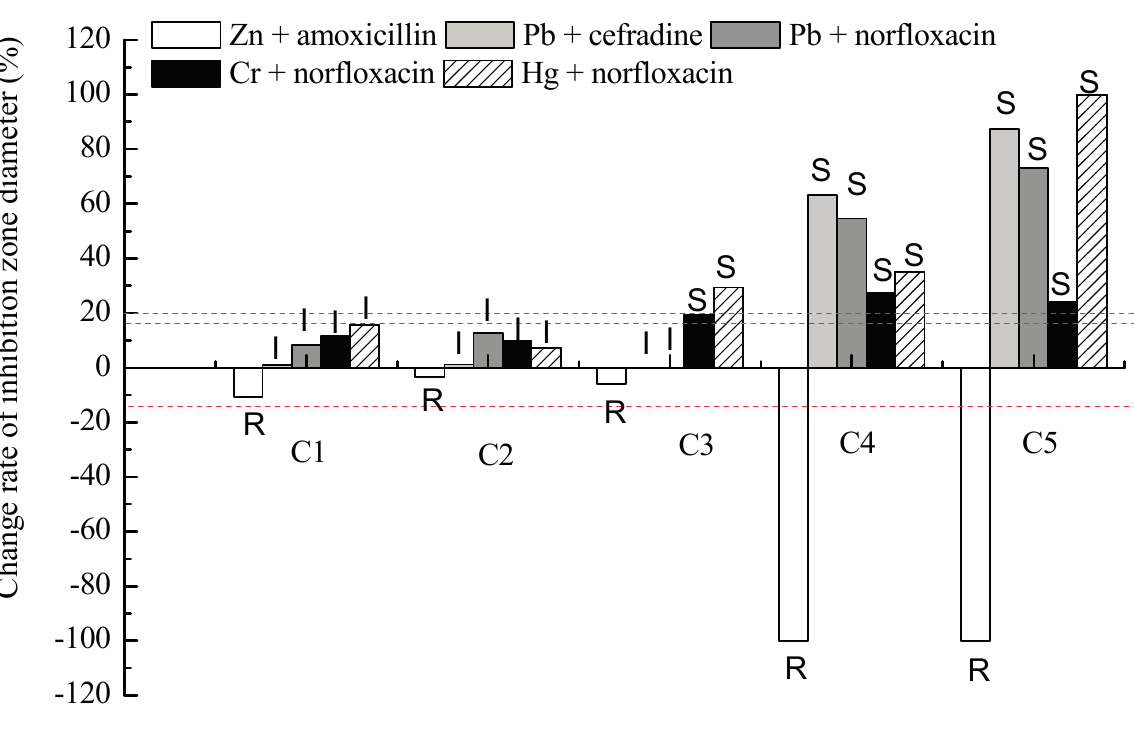
(Figure 4). The susceptibility of P. fluorescens ZY2 to tetracycline turned out to be sensitive when the concentrations of Hg, Pb, Cr and Cu were more than 5, 100, 80 and 100 mg/L, respectively, while the effect of Zn on bacterial susceptibility to tetracycline was minimal, which was about the same as the toxicity order of the heavy metals. Therefore, the heavy metal resistance and the antibiotic resistance might be either synergistic or antagonistic, which depended on the specific type and concentration of the heavy metal. Moreover, we should pay more attention to the phenomenon that bacterial resistance to antibiotics could be enhanced by some heavy metals of certain concentrations.